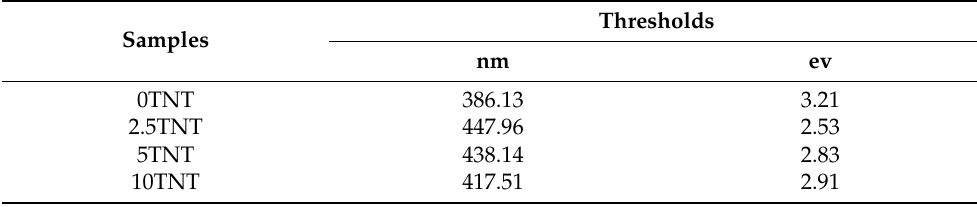
Figure 5. UV-Vis curves of the samples. Table 2. Thresholds for photoabsorption of the sample.